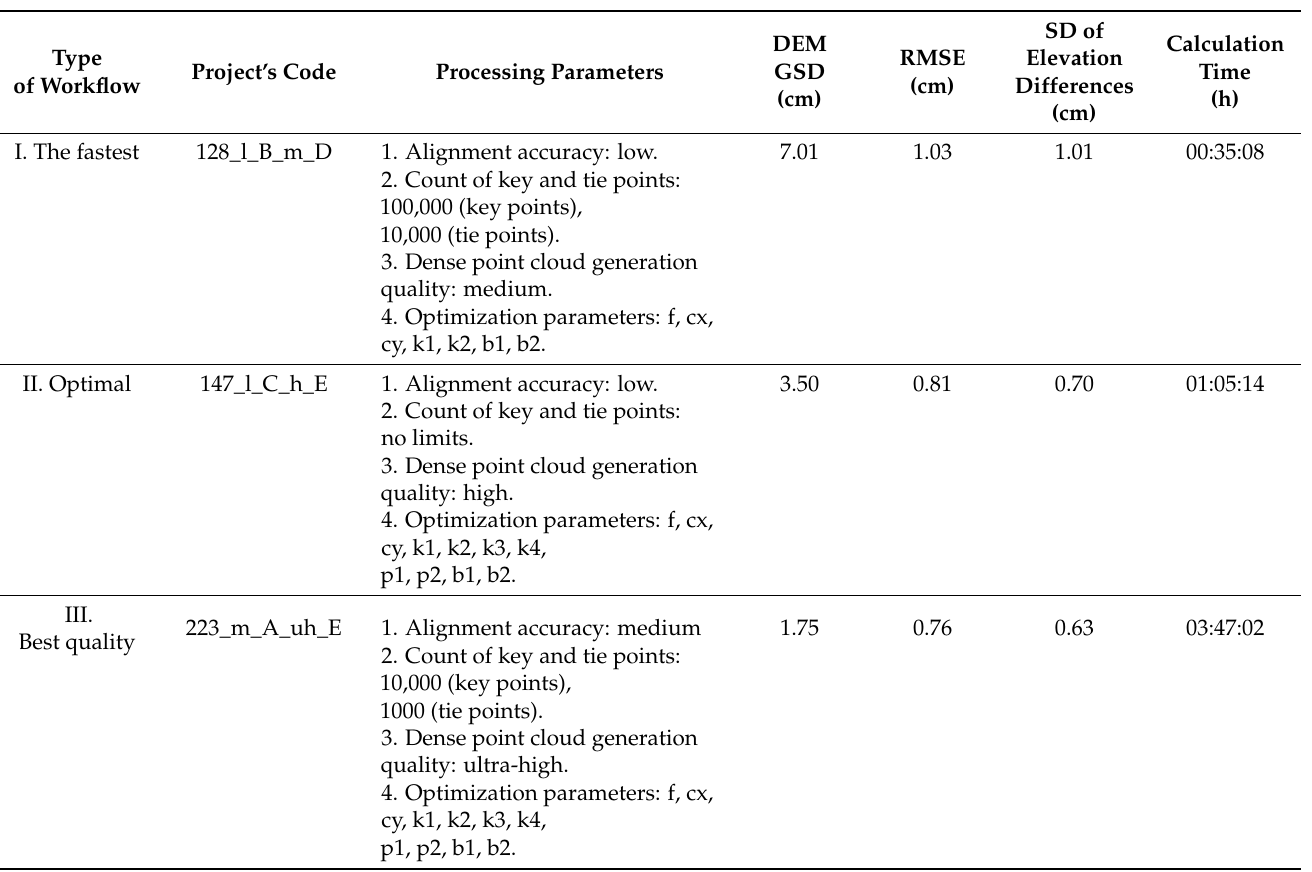
Table 2. Detailed description of the three workflows that meet the requirements formulated in view of the research aims. The difference in the SD of CP errors between workflows I and II is 0.38 cm, and between II and III only 0.07 cm. However, the workflows differ from each other mainly in terms of the time of calculations, which in the I type was more than seven times faster than the III type. The conclusion is that setting higher levels of accuracy in the software is not always appropriate (remembering that the total calculation time depends mainly on the computing